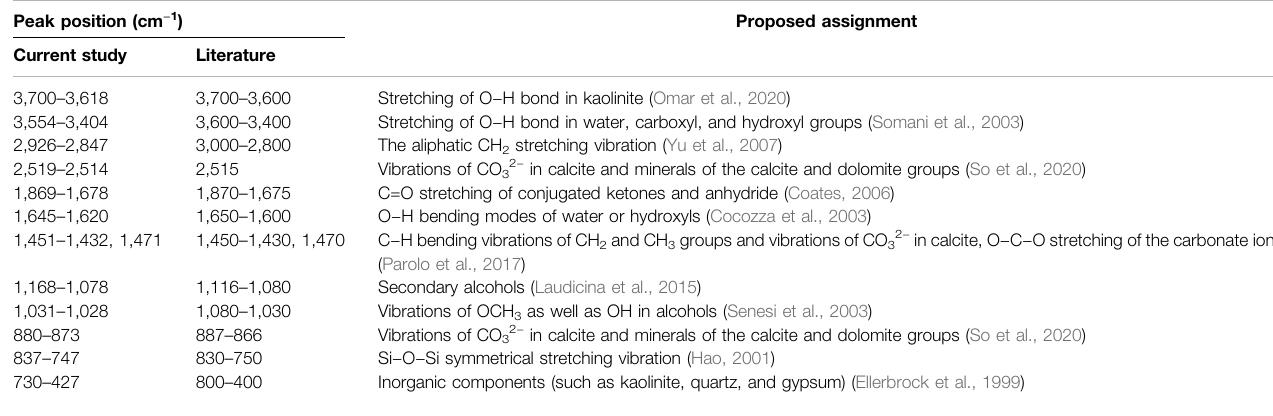
TABLE 3 | FTIR spectra band positions observed in the present study and reported in previous